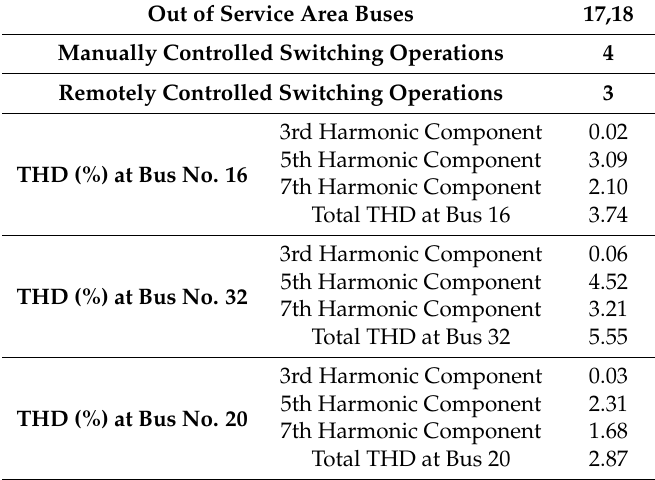
Table 11. Optimal values through Non-Dominated Sorting Genetic Algorithm-II (NSGA-II) restoration plan when DC drive load is present.